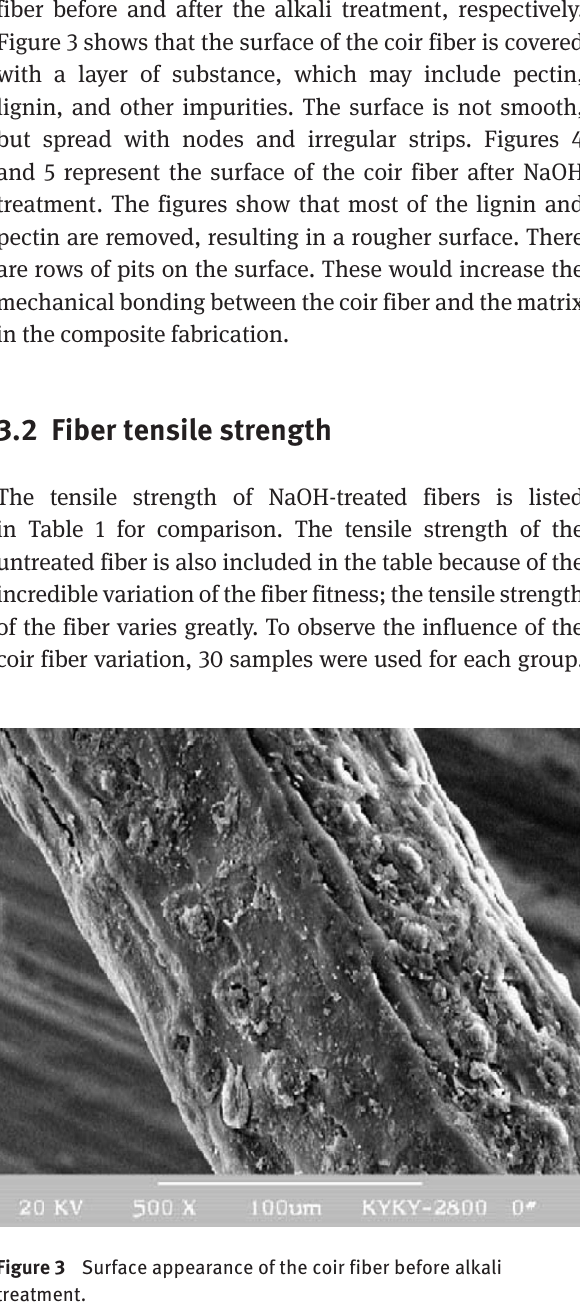
Figure 2 Universal tensile tester model Instron 3369.